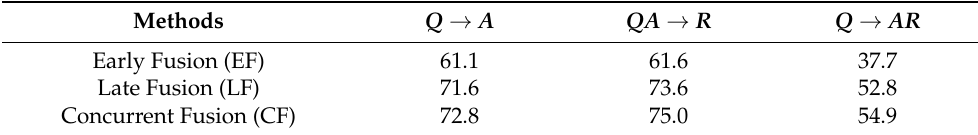
Table 2. Comparison between the multimodal embedding